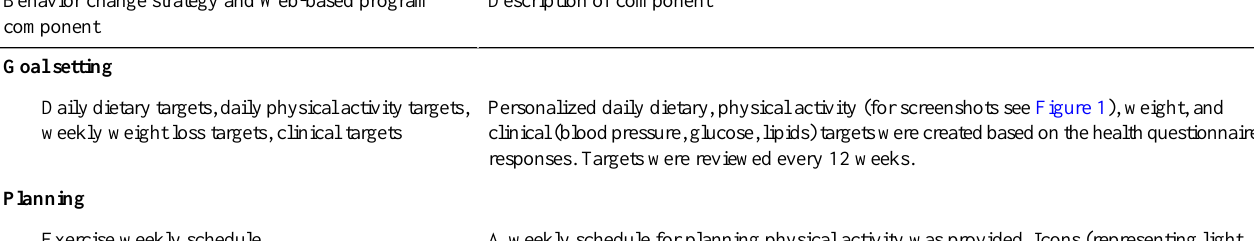
Description of componentBehavior change strategy and Web-based